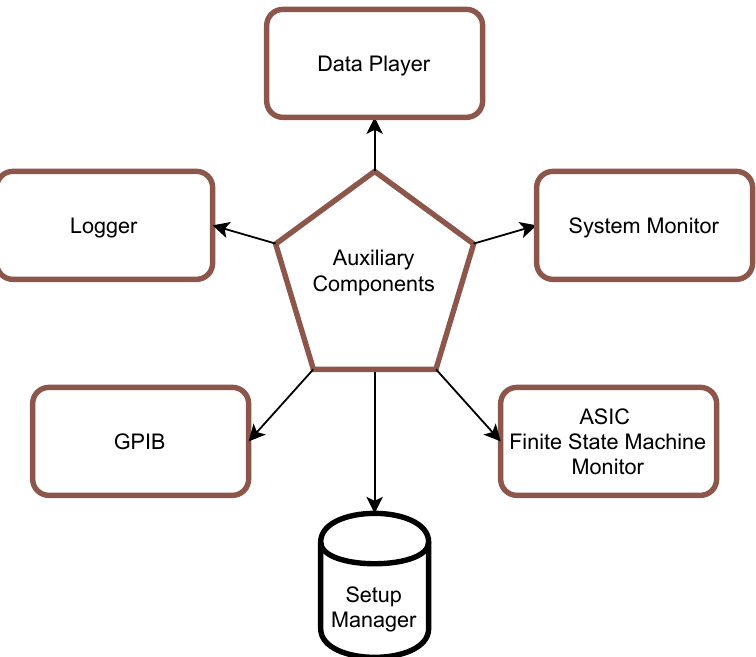
Figure 6. Auxiliary Components of the Server Application . Most of them: Logger , System Monitor , ASIC Finite State Machine Monitor are monitoring tools. Data Player allows replaying past experiments.